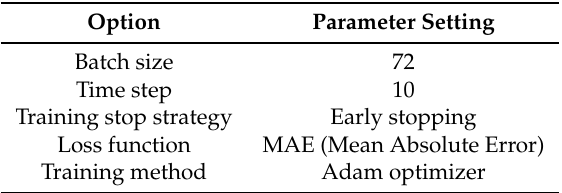
Table 2. The parameter setting detail of the proposed model.